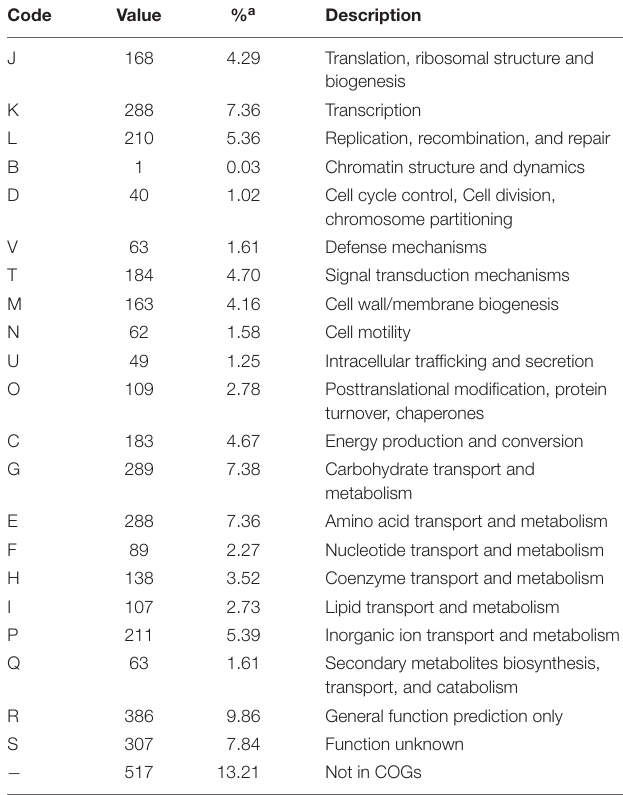
TABLE 5 | Number of genes associated with general COG functional